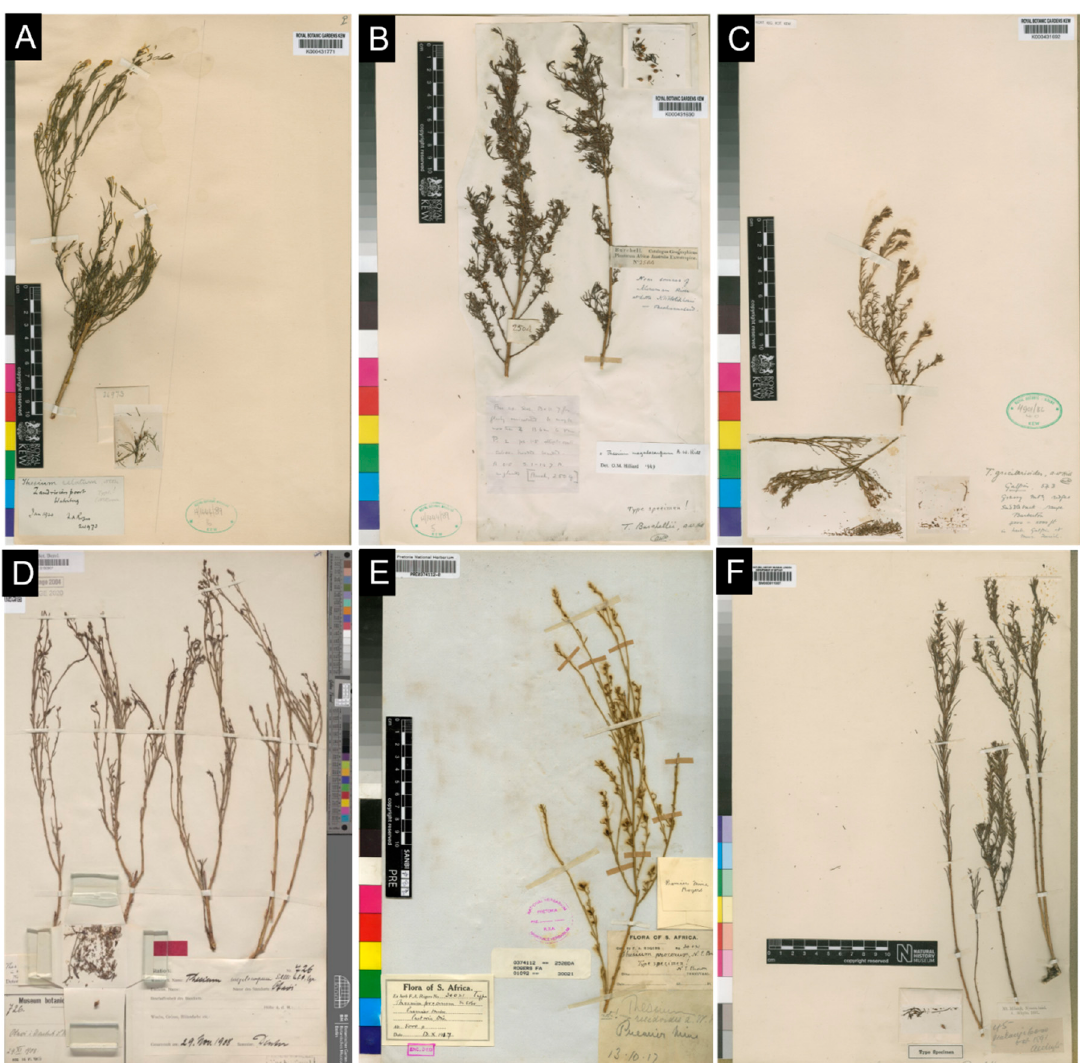
Figure 1. Scans of representative herbarium specimens of Thesium celatum ( A ) and five morphologically similar species T. burchellii ( B ), T. gracilarioides ( C ), T. megalocarpum ( D ), T. procerum ( E ), and T. whyteanum ( F ). Images reproduced with the consent of © The Board of Trustees of the Royal Botanic Gardens, Kew ( A – C ) (http://specimens.kew.org/herbarium/K000431771, http: //specimens.kew.org/herbarium/K000431630, http://specimens.kew.org/herbarium/K000431692, accessed on 17 November 2022); © Botanic Garden & Botanical Museum Berlin, Freie Universität Berlin, Germany ( D ); © South African National Biodiversity Institute ( E ); and © The Trustees of the Natural History Museum, London, England, reproduced under the terms of the Creative Commons Attribution License (CC BY 4.0) ( F